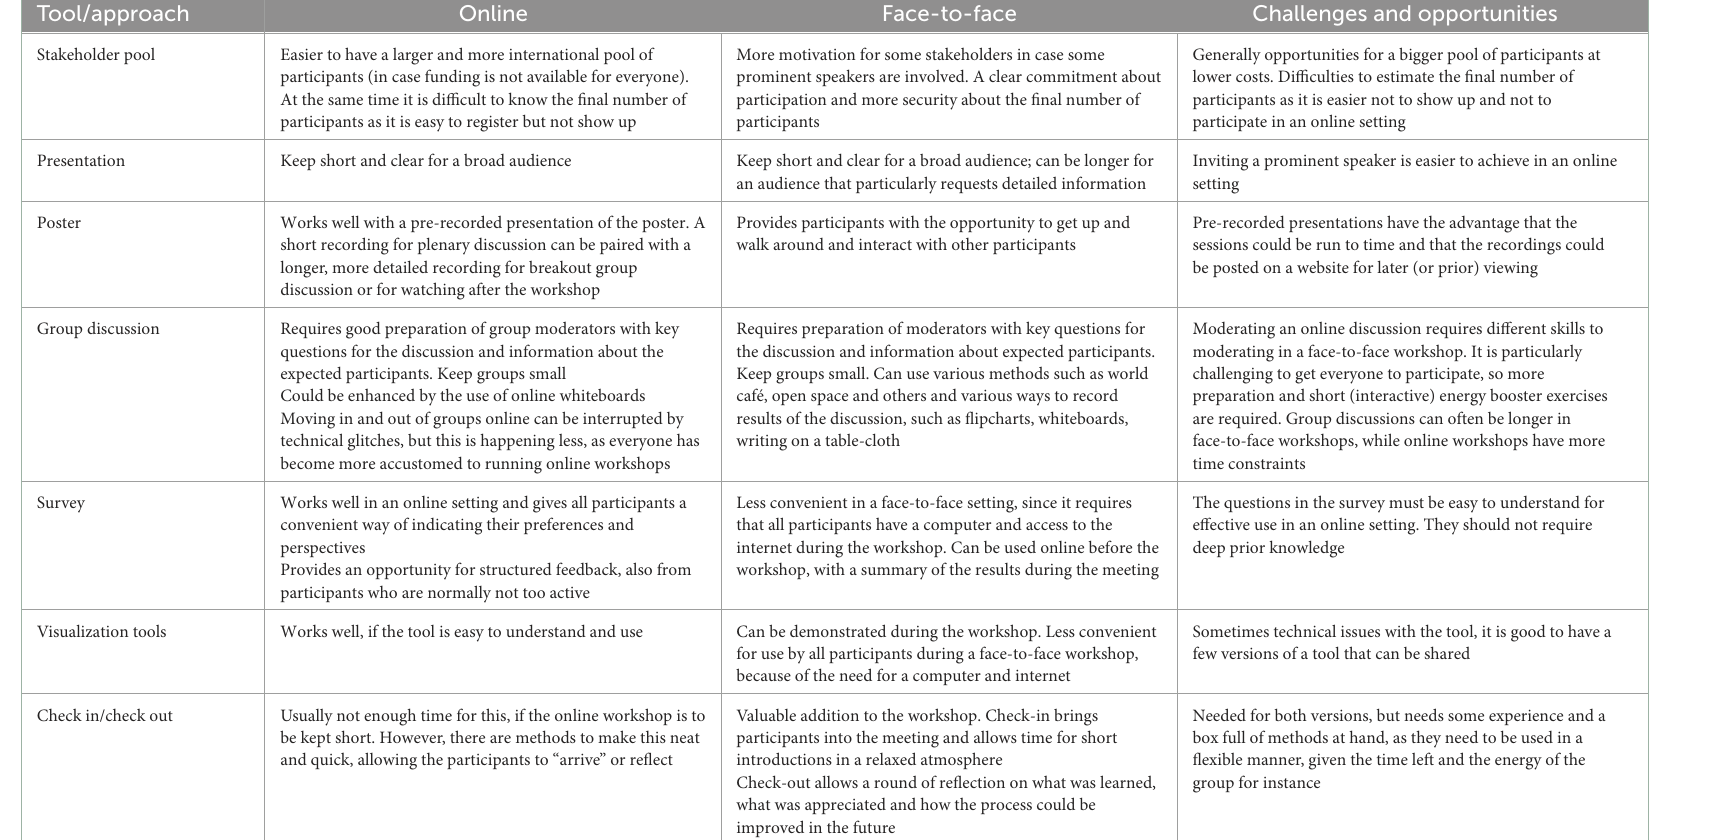
TABLE 4 Comparing tools and approaches for online and face-to-face stakeholder engagement. Tool/approach